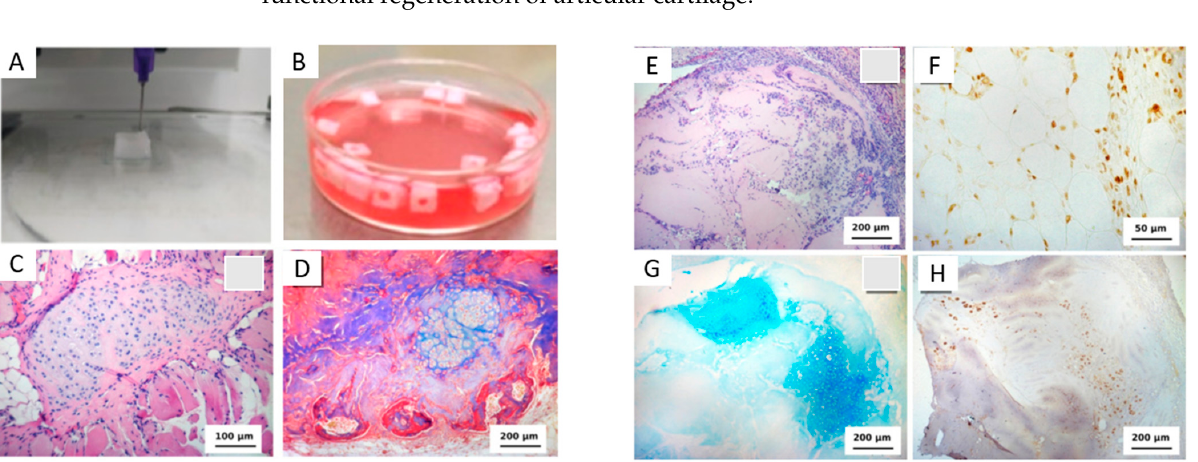
Figure 2. Recent approaches to regenerate articular cartilage have used cartilage ECM and ECM- component ink, in combination with cells. ( A , B ) The printing process uses high concentration collage and chondrocyte ink, and the results in scaffolds retain their three-dimensional shape (as shown in ( B )). ( C ) Hematoxylin and eosin staining of the cartilage tissue that formed after 12 days in culture. Cartilage formation is observed within the striated muscle tissue (20 × magnification). ( D ) Mason’s trichrome staining shows bone tissue formation (in the lower section of the image; 10 × magnification). ( E ) Five days after implantation, ( H , E ) staining shows cellularity within the scaffold (10 × magnification). The scaffold in five days after the implantation. ( F ) PCNA-positive nuclei of chondroblasts and proliferating cells in the connective tissue capsule (40 × magnification). ( G ) Glycosaminoglycans staining in blue shows cells are producing components of native cartilage matrix (10 × magnification). ( H ) Staining for type II collagen (brown) shows additional components of the cartilage matrix are being produced by the metabolically active cells (10 × magnification). Taken together, three-dimensional printing of cartilage with custom bioinks is a recent and viable strategy for cartilage tissue engineering studies. Adapted from Beketov et al. (2021) with